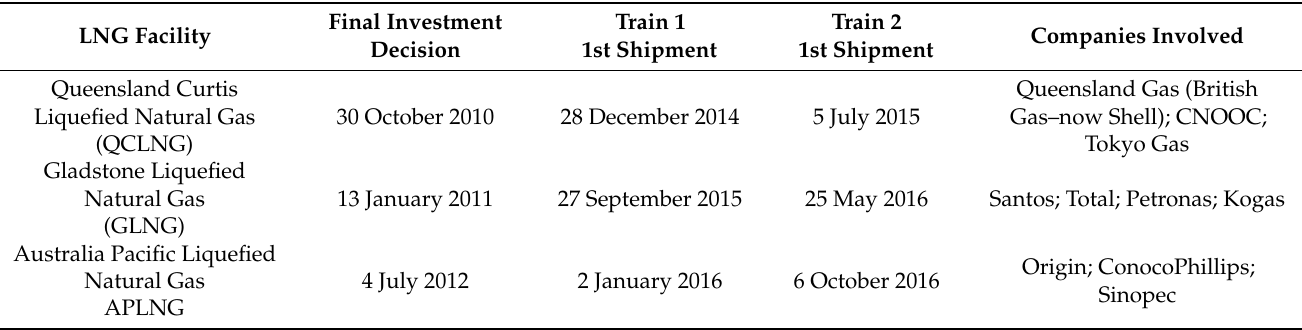
Table 1. CSG to LNG projects in